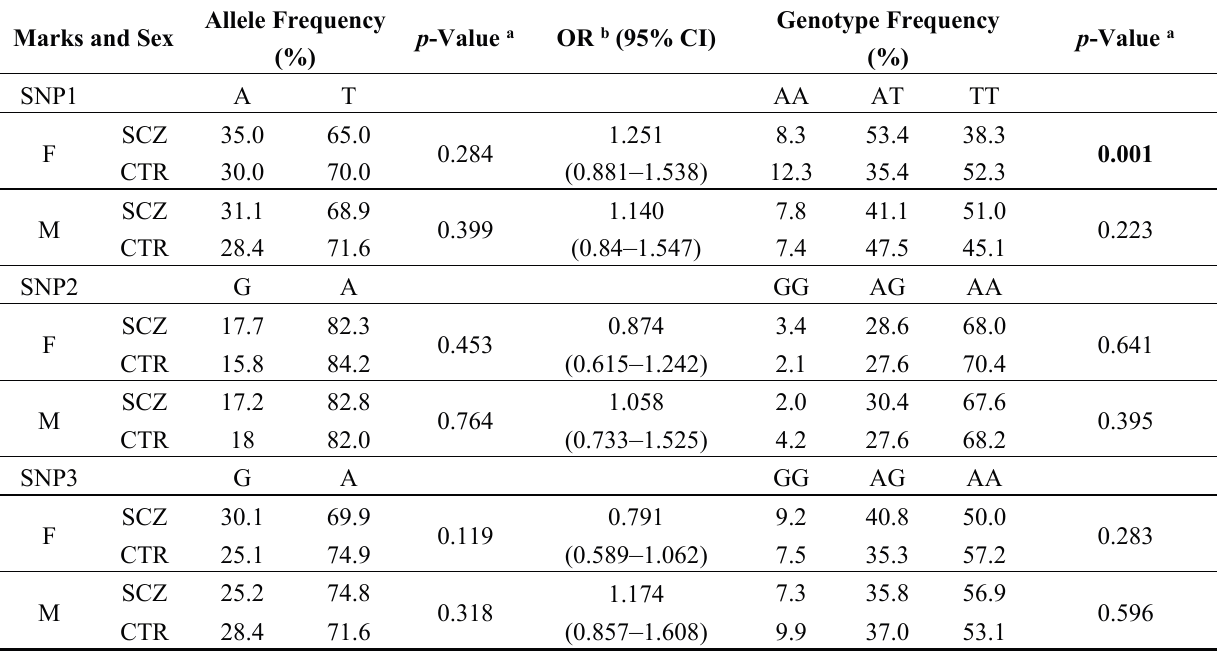
Table 2. Sex-specific allele and genotype association